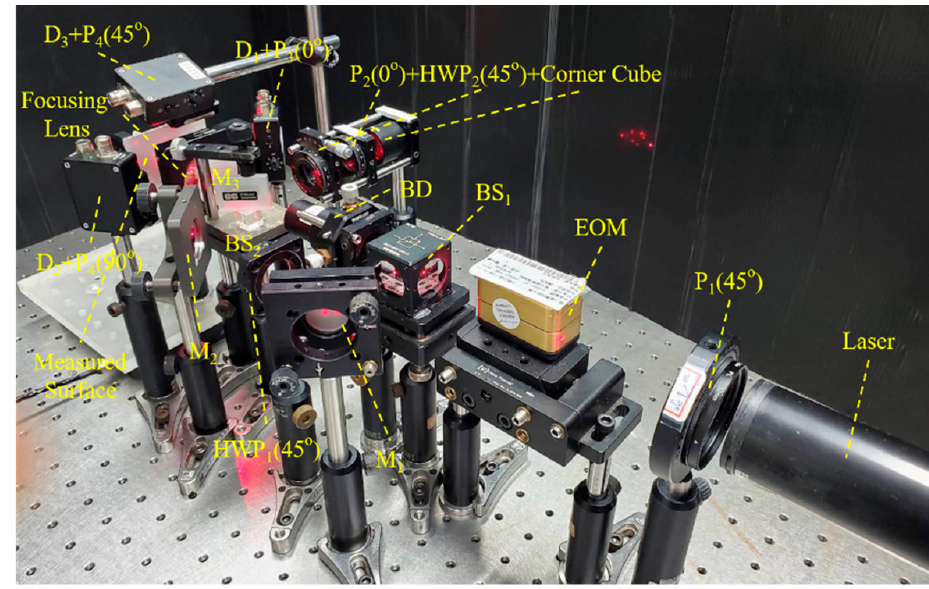
Figure 4. Compound speckle interferometer performance test setup.